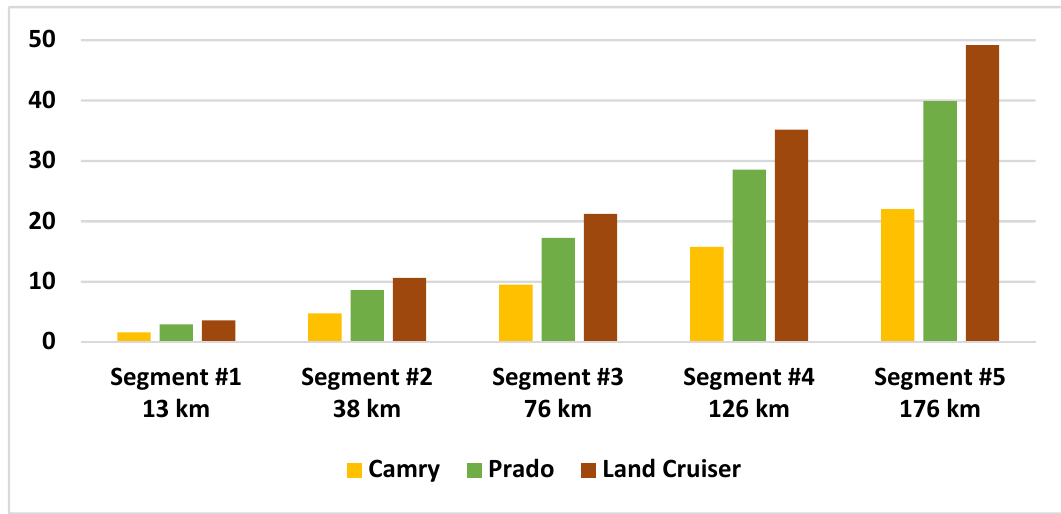
Figure 4 indicates that CO 2 tailpipe emissions increase rapidly as driving range and en- gine size increase, the highest emissions being in Segment #5, at 22.02, 39.90, and 49.15 kg/L for the Camry, Prado, and VXR, respectively.